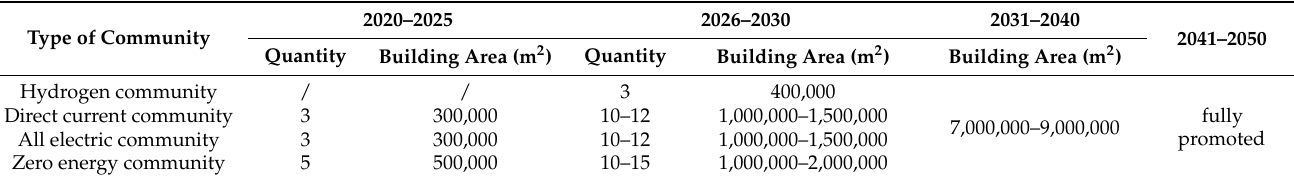
Table 6. Low-carbon communities planning scheme.